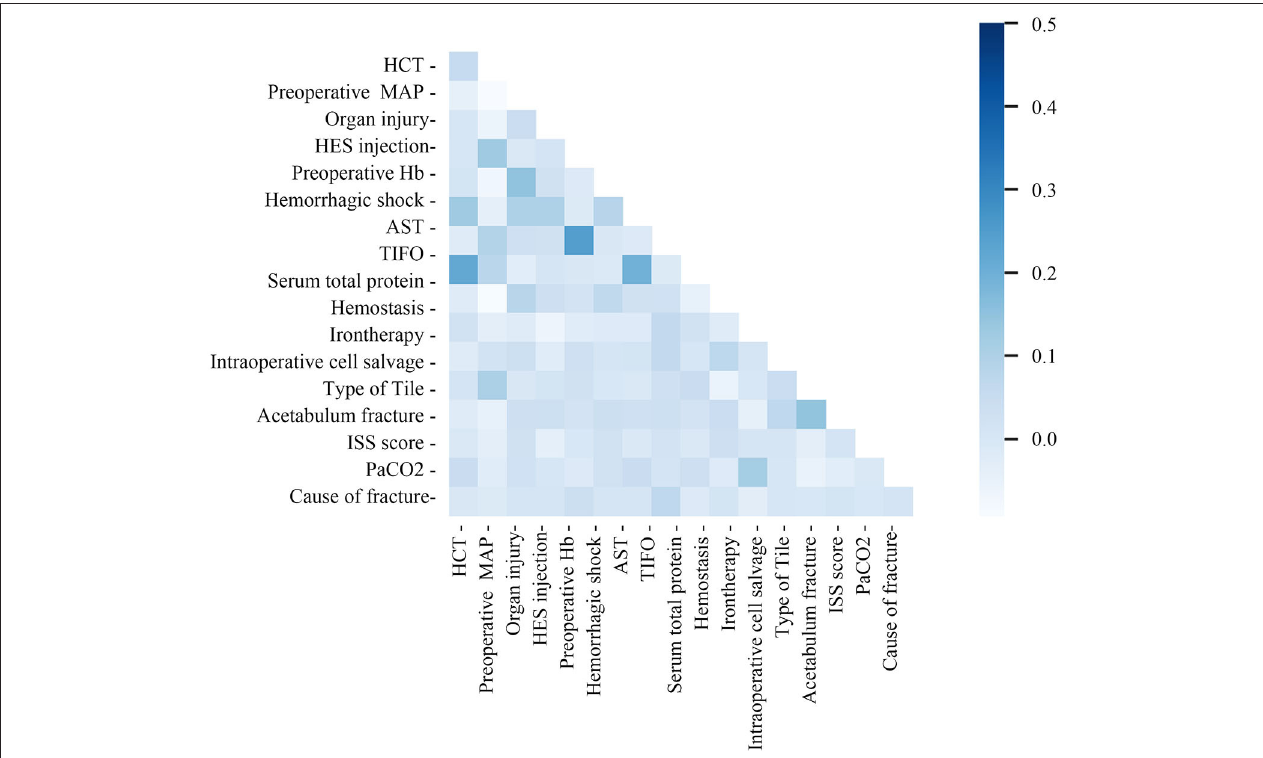
FIGURE 2 | Correlation matrix of features included within machine learning algorithms in transfusion predictive model. MAP, preoperative mean arterial pressure; TIFO, time from the injury and the first operation; AST, aspartate transaminase; HCT, hematocrit; ISS, injury severe score; PaCO 2 , partial pressure of carbon dioxide; HES, hydroxyethyl